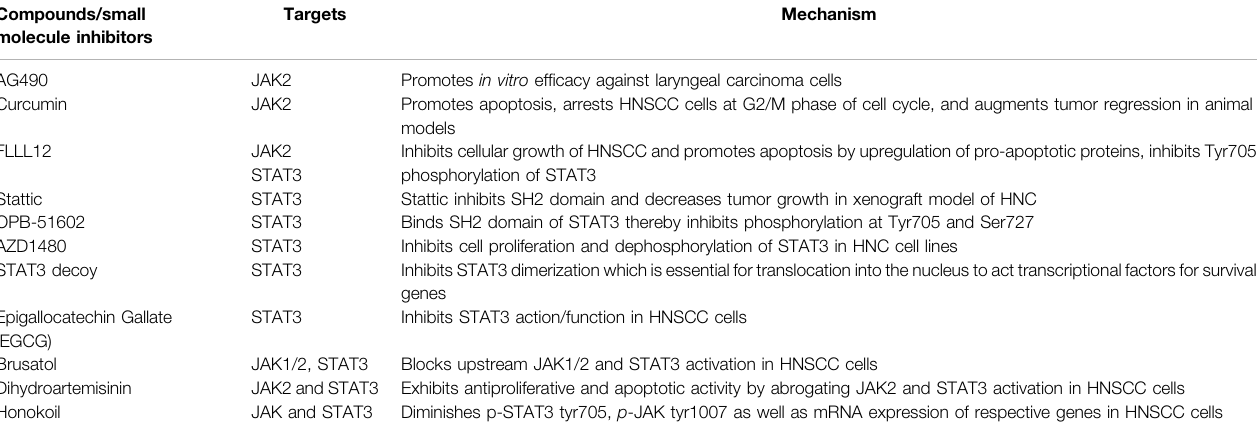
TABLE 5 | JAK/STAT signaling modulators, their targets, and mechanism in head and neck squamous cell carcinoma (HNSCC)/cells. Compounds/small molecule inhibitors